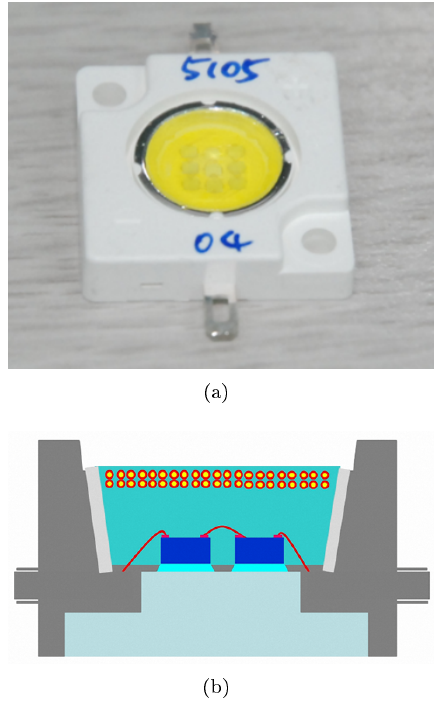
Fig. 1: (a) The real model WLEDs; (b) The simulation remote-packaging WLEDs. In the simulation model Figure 1(b), the con- centration of α -SrO · 3B 2 O 3 :Sm 2+ should be